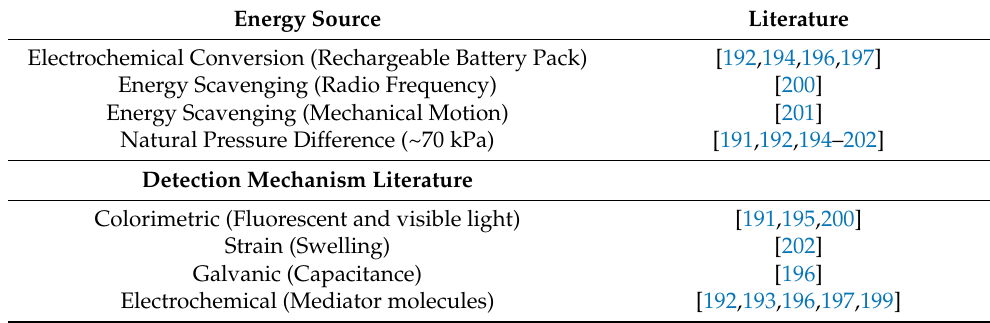
Table 3. The reported energy sources and utilized detection mechanisms in microfluidic